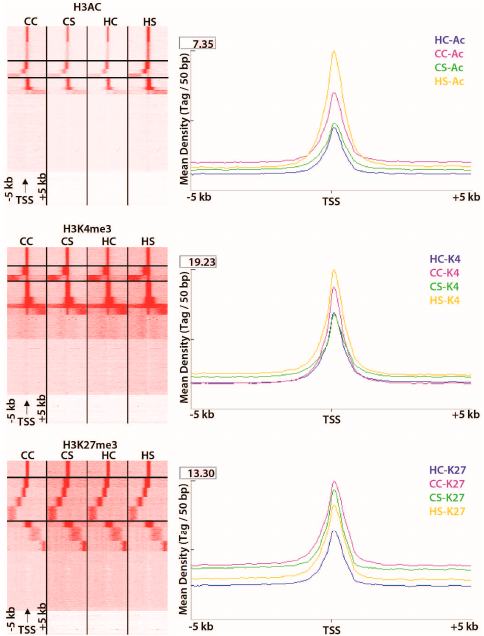
Figure 4. High fat and diabetes-induced genome wide differential histone marks. Heat maps showing read density along with corresponding mean density (tag/50 bp) plots in ±5 kb of any known transcriptional start site for H3Ac, H3K4me3, and H3K27me3 modifications clustered and visualized as four panels in the order of CC (control), CS (diabetes exposed), HC (diet exposed), and HS (combination exposed) from left to right. From the vertical view, clusters with the central density profile are located at the top, followed by clusters with peaks in the − 5 kb region (marked within the black lines), those with peaks in the +5 kb region, those with diffuse read density, and those without significant read density.